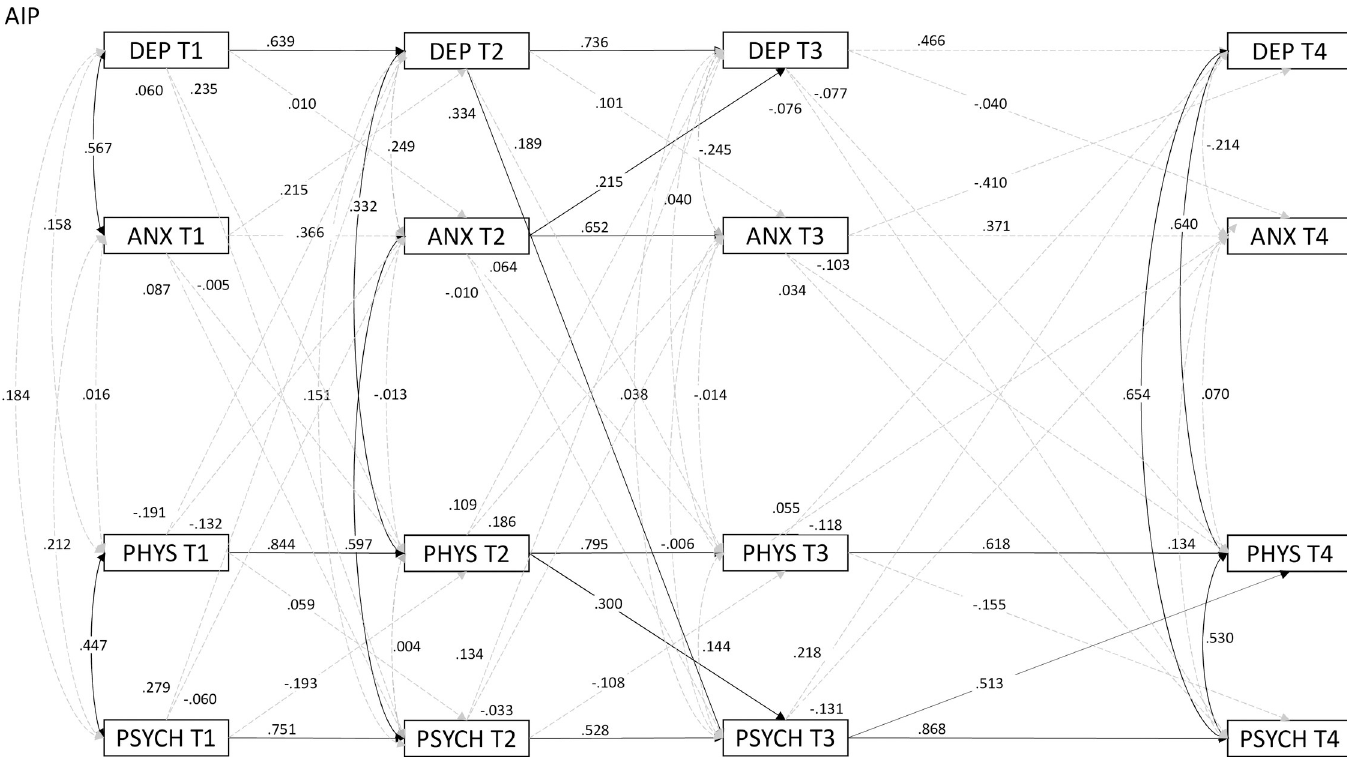
Fig 2. Cross-lagged panel model of MSIS-29 and HADS over four timepoints for AIP ( n = 30). Note : Solid arrows are p < .05; dashed arrows are nonsignificant; numbers above arrows indicate standardized coefficients.